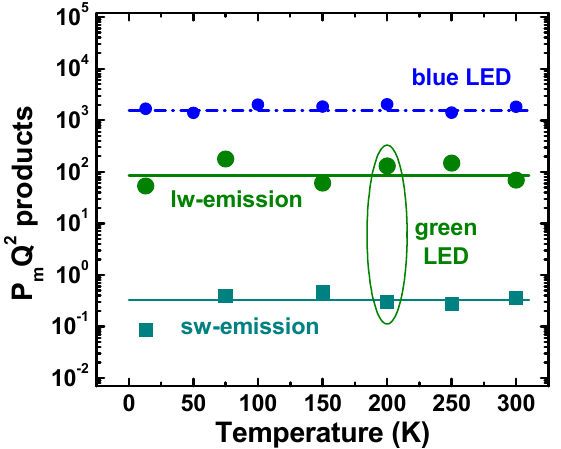
Figure 7. P m Q 2 product as a function of temperature plotted for sw- and lw-emission of green LEDs. Big symbols are experimental points, solid lines are drawn for eyes. Data for blue LEDs reported in [5] are also shown for comparison by small circles and dash-dotted line.